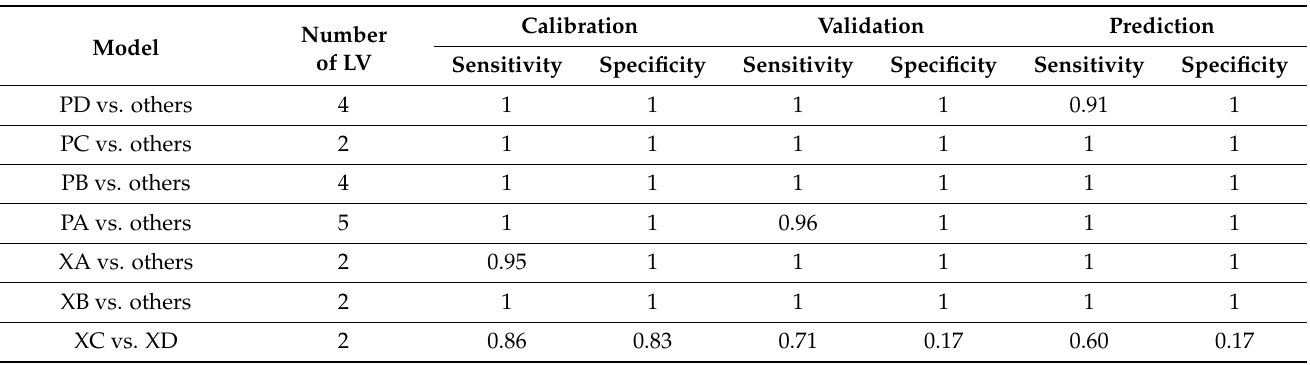
Table 1. Results from two-class classification models obtained by PLS-DA according to the calibration tree shown in Figure 6. The calibration set comprises the 60% of all samples randomly chosen and the prediction set the 40% remaining